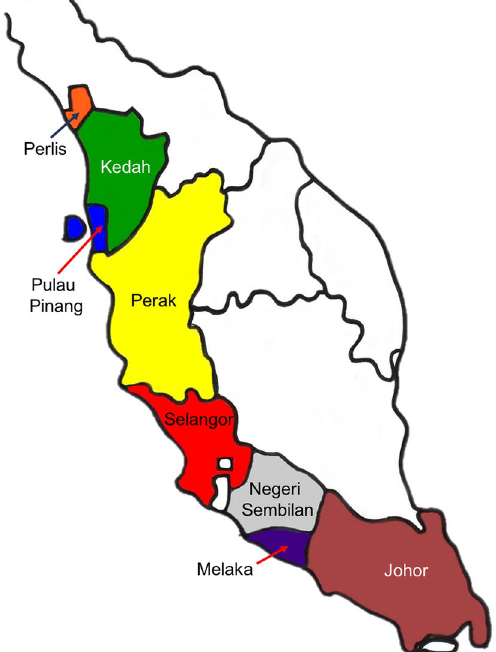
Figure 4. Sampling sites of diseased Theobroma cacao in several states of